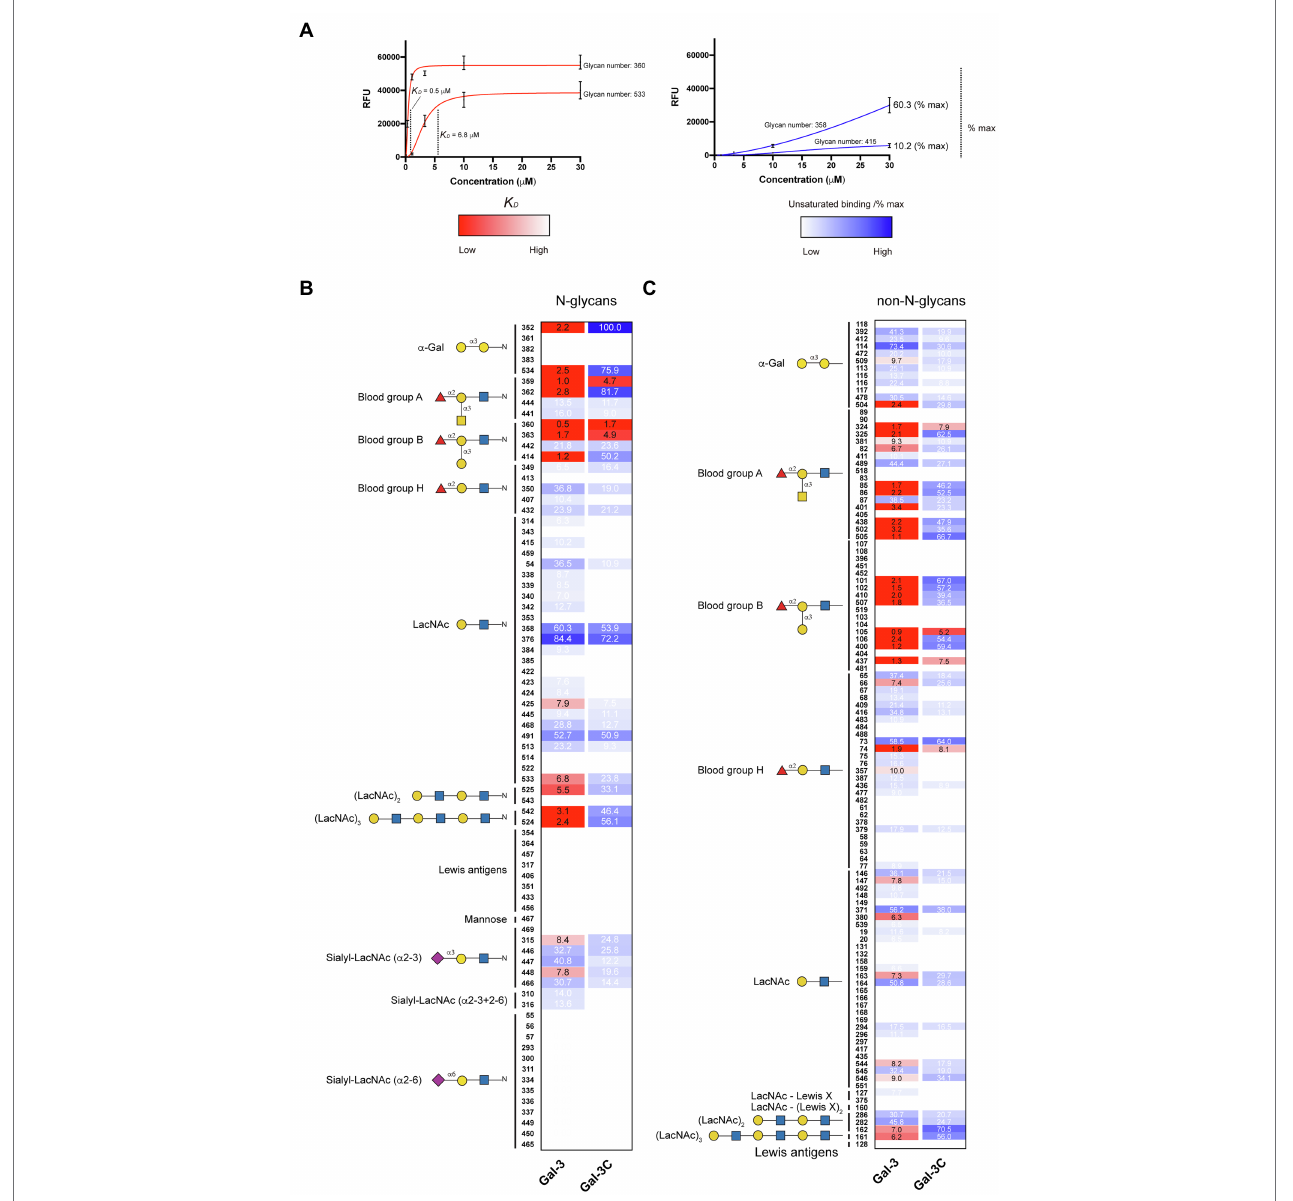
FIGURE 3 | K D values for Gal-3 and Gal-3C binding toward blood group antigens and other mammalian glycans. (A) Representative binding isotherms used to generate K D values and the % max of the highest concentration tested for unsaturated glycans. (B,C) Selected blood group antigens were shown along with heat map representation of K D values (red) and the % max of the highest concentration tested for unsaturated glycans (blue) for antigens located on N-glycans (B) and non-N-glycans (C) . The heat map from darker red (low K D ) to light red (high K D ) is shown. For the unsaturated binding, the heat map from light blue (low % max) to darker blue (high % max) is shown. Examples of glycans examined are annotated to the left of each heat map as structures that are present on N-glycans (N-glycans) as shown in (B) or as the isolated glycan motifs (non-N-glycans) as shown in (C)